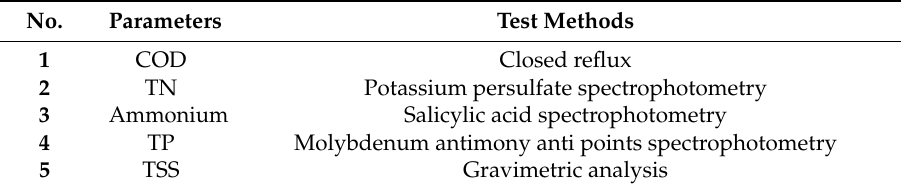
Table 2. Test methods used for analysis [26].